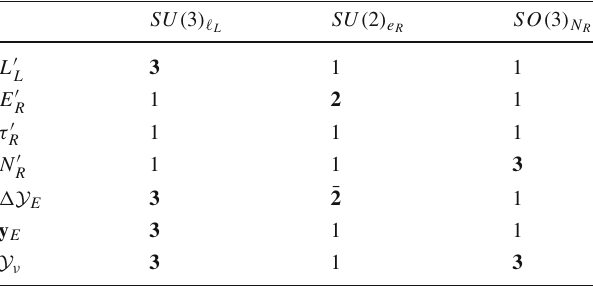
Table 3 Transformation properties of leptons and leptonic spurions under G EFC